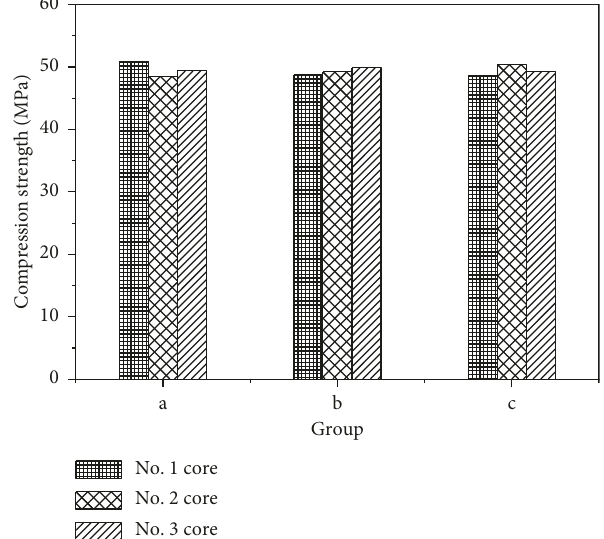
Figure 9: Core sample compression strength of each group.